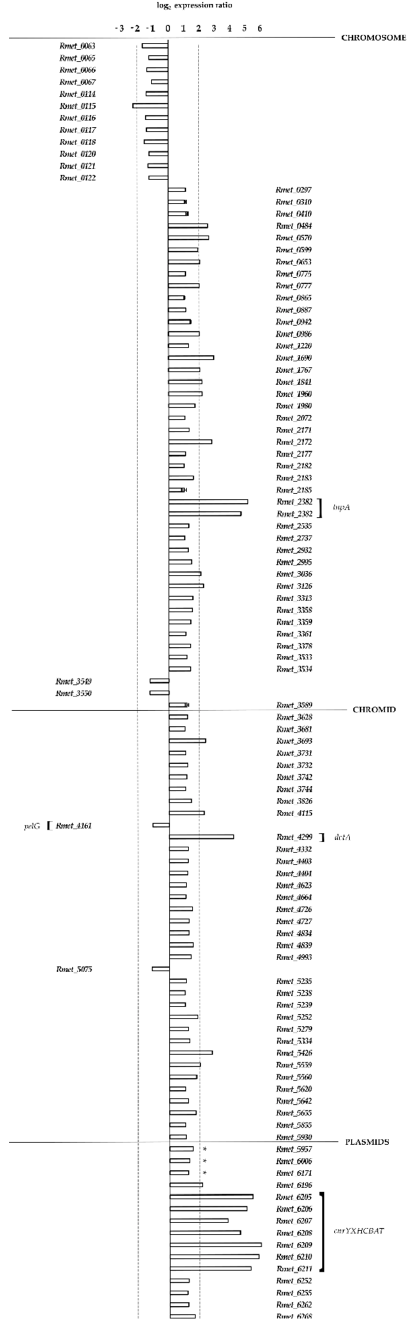
Figure 2. Transcriptional changes in C. metallidurans MSR33 with respect to CH34, with both strains grown under equal and nonselective conditions (see methods). Bar graphs show the significantly ( p -value < 0.05) higher expression (log 2 ratio > +1) and lower expression (log 2 ratio < − 1) of MSR33 genes (with CH34 gene expression levels as reference). Transcriptional changes from genes pertaining to all replicons are depicted. Genes indicated with an * are part of